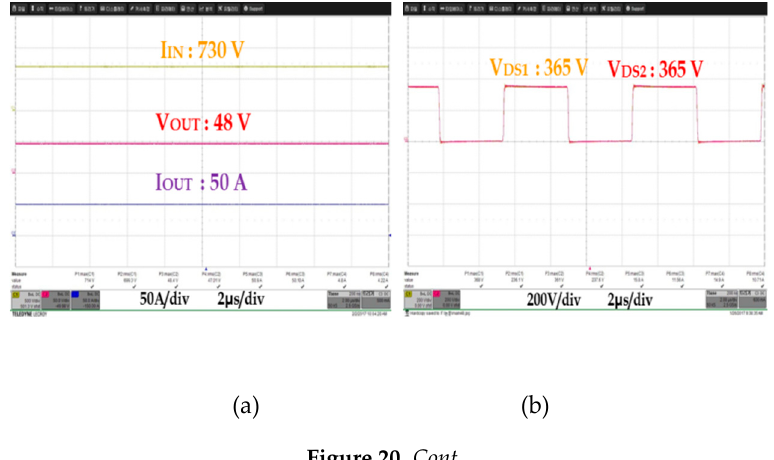
Figure 19. Experimental waveforms of the proposed converter (10% load). ( a ) Input and output voltage and output current; ( b ) FET D–S waveform; ( c ) input cap. voltage/resonant current waveform; ( d ) voltage/current of the rectifier diode.